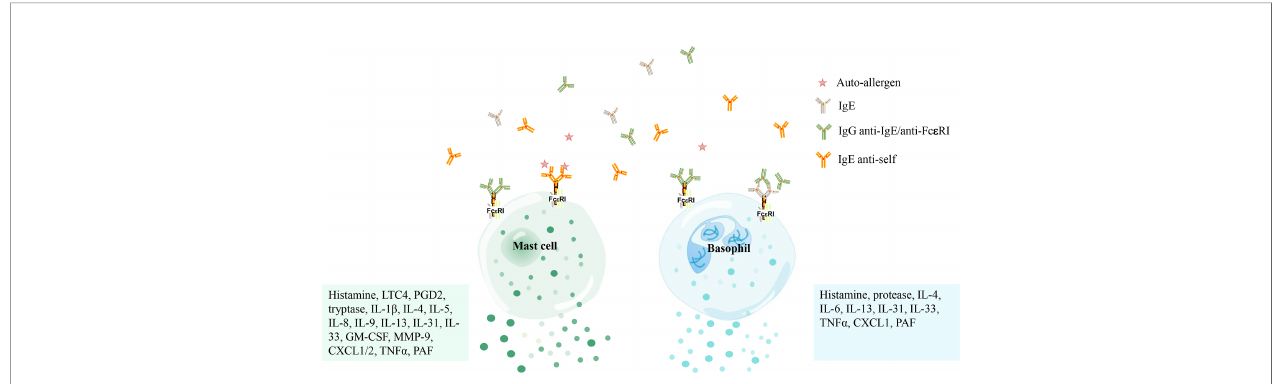
FIGURE 2 | The activation of mast cells and basophils in patients with chronic spontaneous urticaria mediated by autoantibodies. Mast cells and basophils are activated by IgE antibodies against its high-af fi nity receptor (Fc ϵ RI) or IgG antibodies against IgE/Fc ϵ RI and release several mediators [i. e. histamine, tryptase, Leukotriene C4 (LTC4), prostaglandin D2 (PGD2), platelet-activating factor (PAF), granulocyte-macrophage colony-stimulating factor (GM-CSF), matrix metalloproteinase-9 (MMP-9), C-X-C motif chemokine ligand 1/2 (CXCL1/2), tumor necrosis factor a (TNF a ), etc.] that concur to produce the marked vasodilation that stands at the basis of both wheal-and fl are reaction and angioedema.